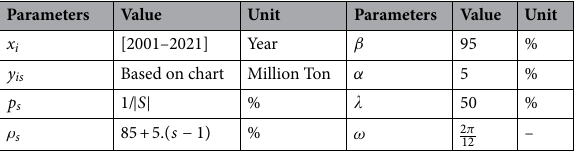
Table 2. Determining the value of parameters. U uniform function